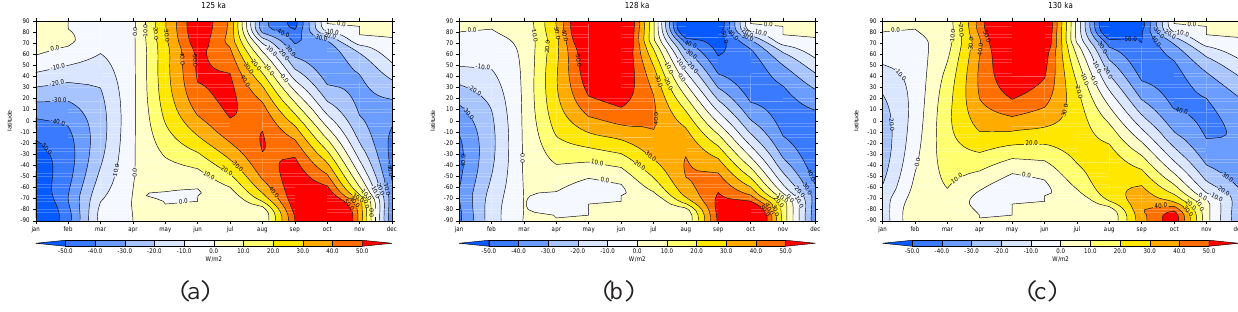
Fig. 1. Insolation at the top of the atmosphere [Wm − 2 ] for (a) 125ka, (b) 128ka and (c) 130ka, relative to modern, as a function of month of the year and latitude, as calculated by the radiation code in HadCM3. The calculation assumes a fixed calendar, with vernal equinox on 21 March; as such, the anomalies in October in the Southern Hemisphere and September in the Northern Hemisphere are largely an artefact (Joussaume and Braconnot,